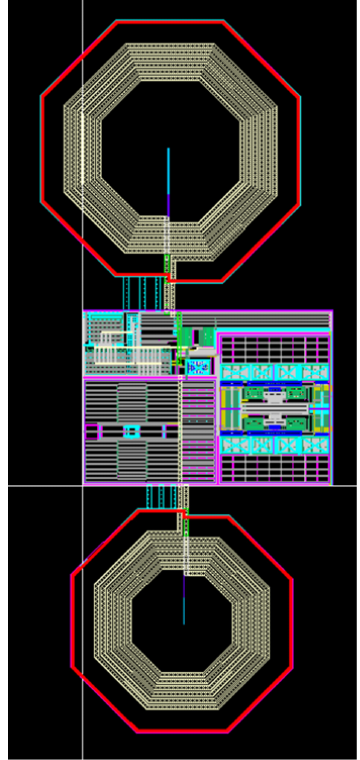
Figure 11. Layout of the final PLL